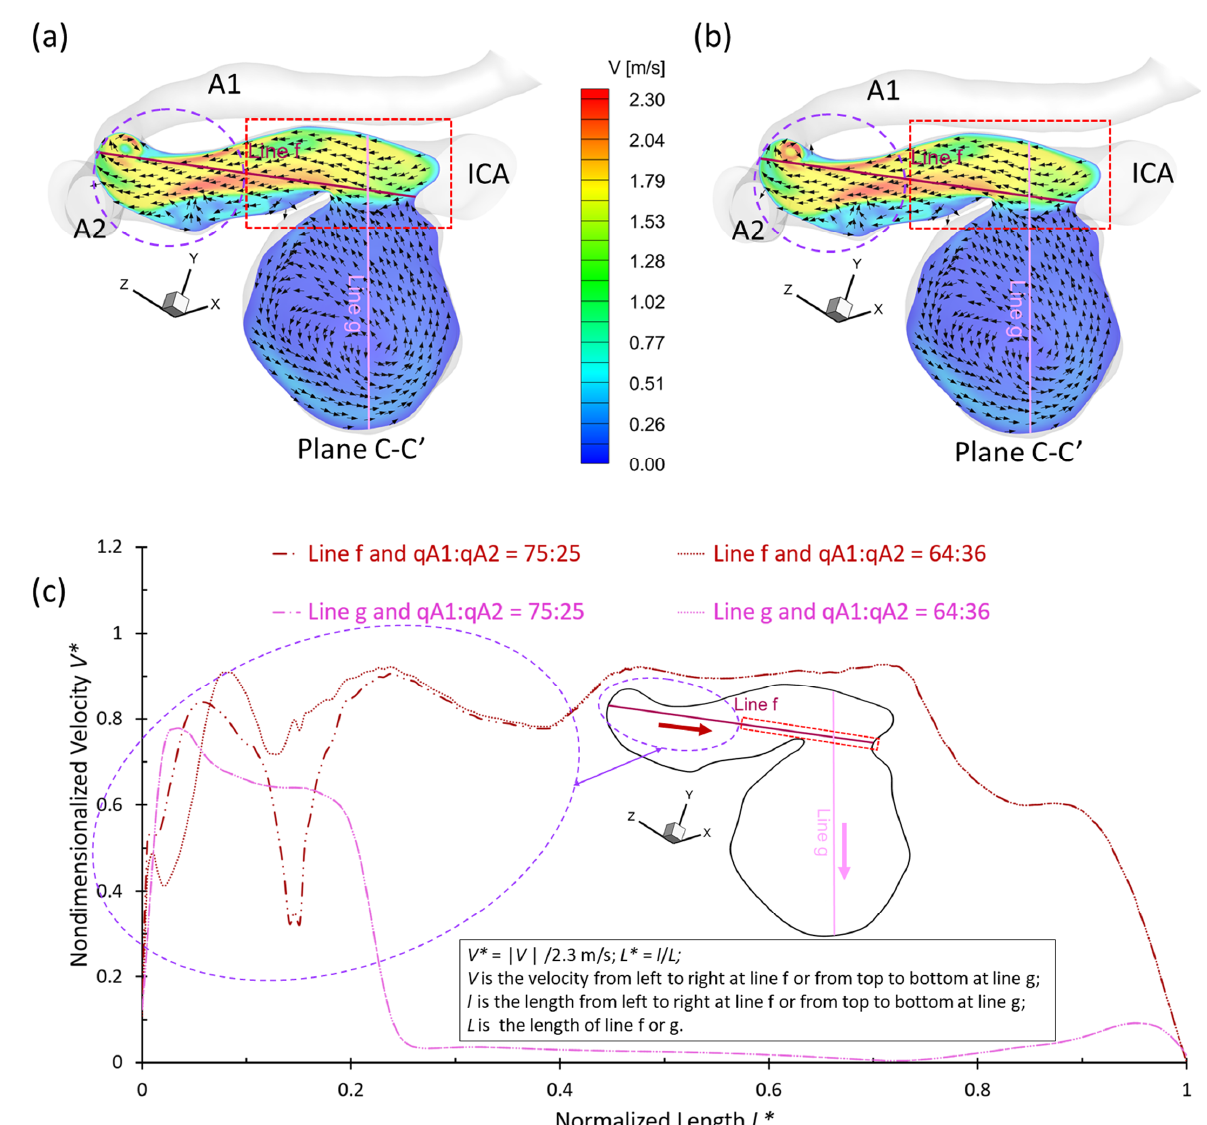
Figure 12. Comparisons of velocity profiles in the extracted plane C−C’ and velocity distributions in selected lines f and g in ICASA−2 model under different bifurcated shunt ratios: ( a ) velocity profiles at plane C−C’ under q A1 :q A2 = 75:25, ( b ) velocity profiles at plane C−C’ under q A1 :q A2 = 64:36, and ( c ) nondimensionalized velocity profiles at lines g and f.